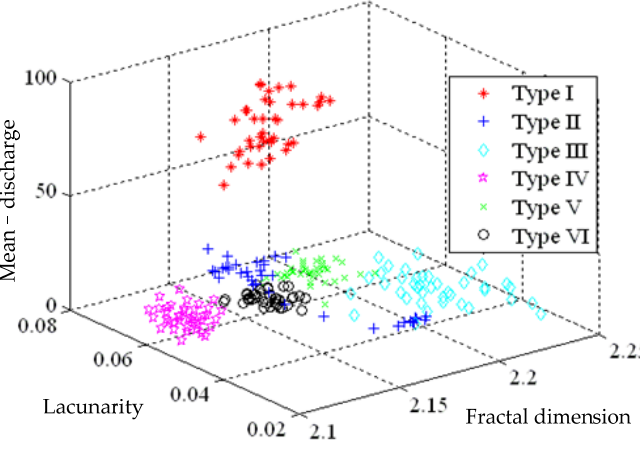
Figure 16. Feature distributions for phase ‐ resolved n ‐ q ‐ φ 3D pattern.